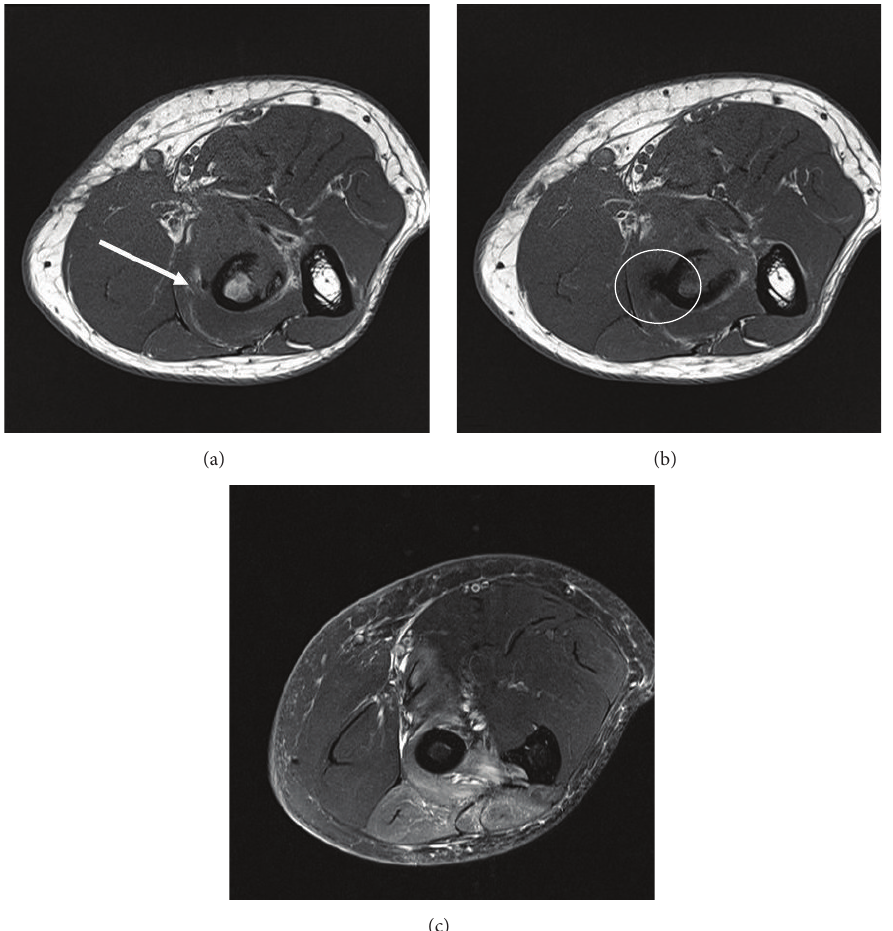
Figure 1: Axial T1 ((a), (b)) and T2 fat saturated images (c) from patient 1. (a) demonstrates the PIN in the supinator tunnel just proximal to the exit point of the radial tunnel posterolaterally where it is clearly identified (white arrow). Slightly more distally, (b), artifact from the cortical fixation button obscures the plane of the PIN (circle). A pattern of muscle edema involving the ECU, EDC, EDM, and supinator muscles is consistent with injury to the PIN in